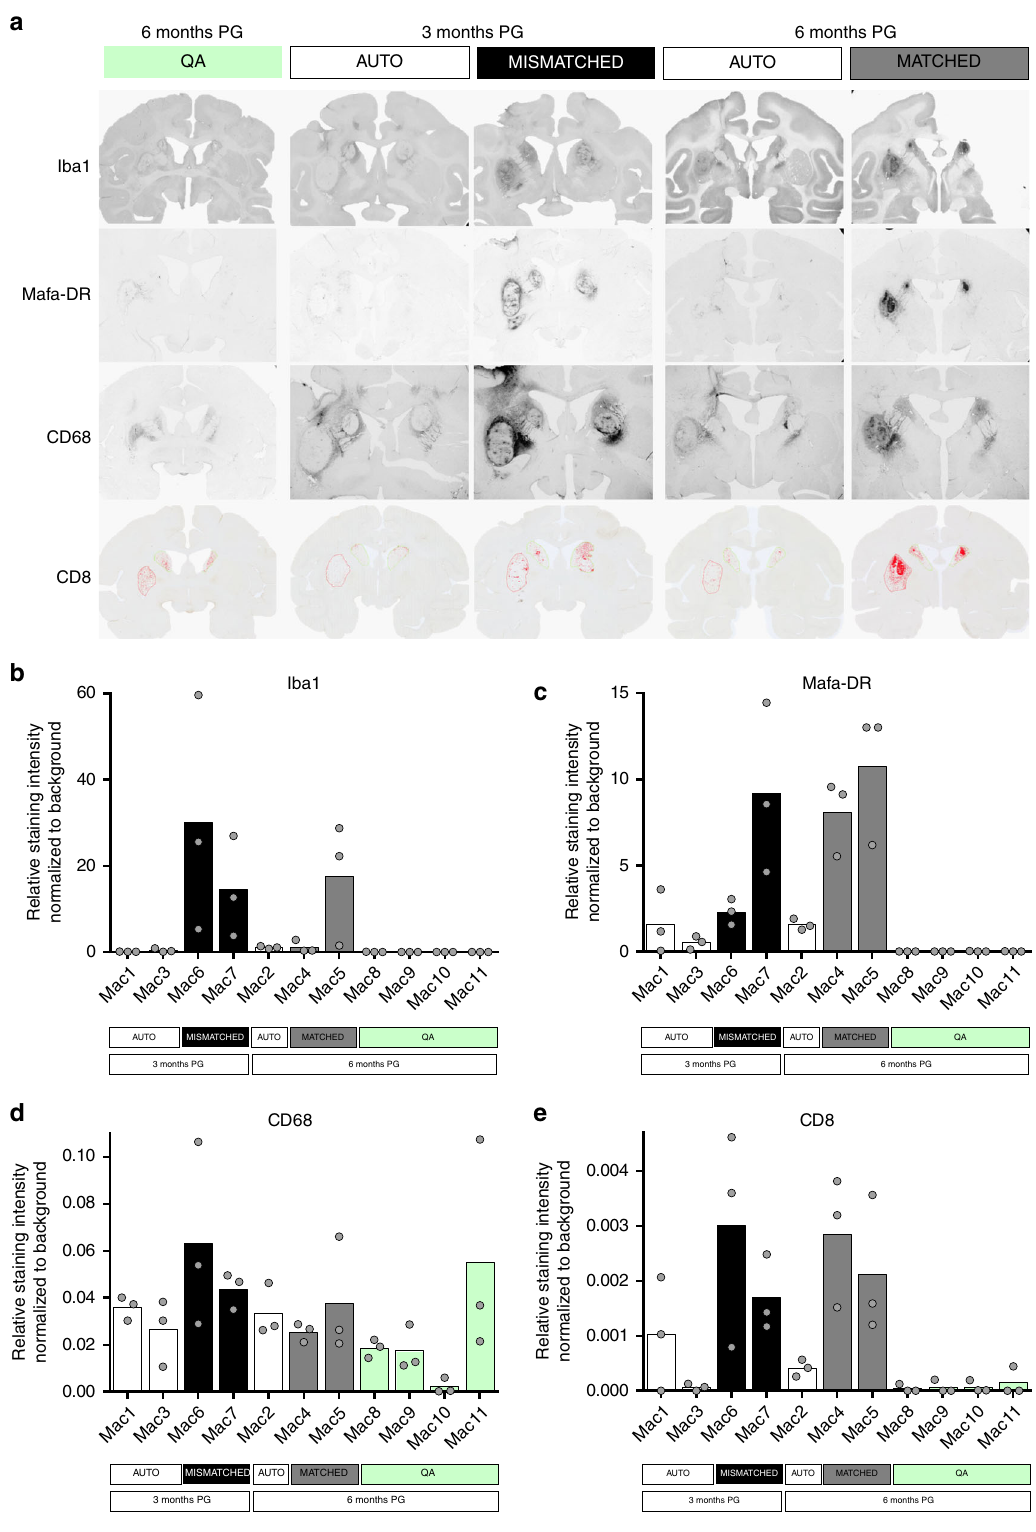
Fig. 6 Post mortem analysis of the immune markers in QA-lesioned NHPs after CTP transplantation. a Representative coronal sections of the NHP brain at the level of the graft (commissural) showing staining for microglia/macrophages (Iba1; CD68), MHC Class II positive cells (revealed by an anti HLA-DR antibody cross-reacting with Mafa-DR antigens), and cytotoxic T-cells (CD8, cartography,) in quinolinic acid lesioned (QA) untransplanted controls (green) and in autologous (AU, white), MHC-matched (MA, gray), and mismatched (MI, black) CTP recipients at 3 or 6 months post-grafting (PG). b – e Quanti fi cation of Iba1 ( b ), Mafa-DR ( c ), CD68 ( d ) and CD8 ( e ) immunoreactivity in AU, MA, MI CTP recipients at 3 or 6 months post-grafting (PG) and in untransplanted controls. Bar graphs represent mean value of the three regions of interest considered (left and right caudate, and left putamen) for each animal; gray dots represent individual values for each region ( n = 3 biologically independent cell deposit per